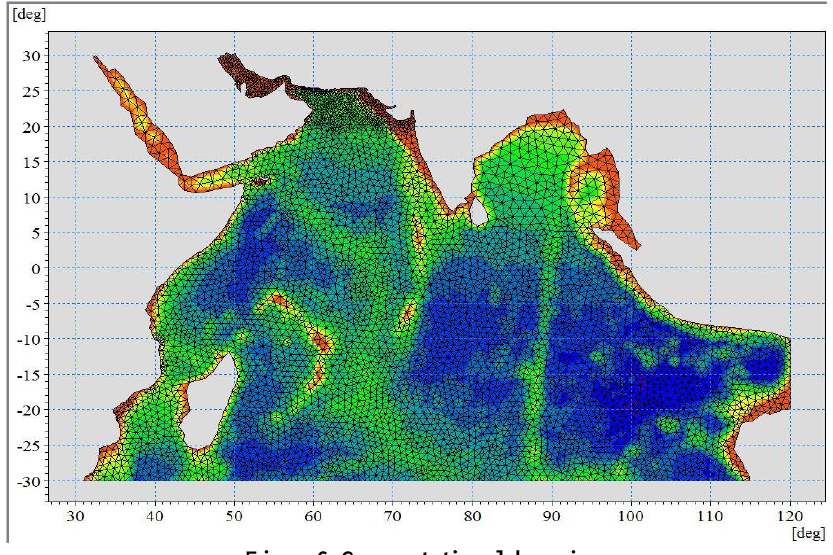
Figure6. Computational